Question: Express in one sentence what the figure is showing.
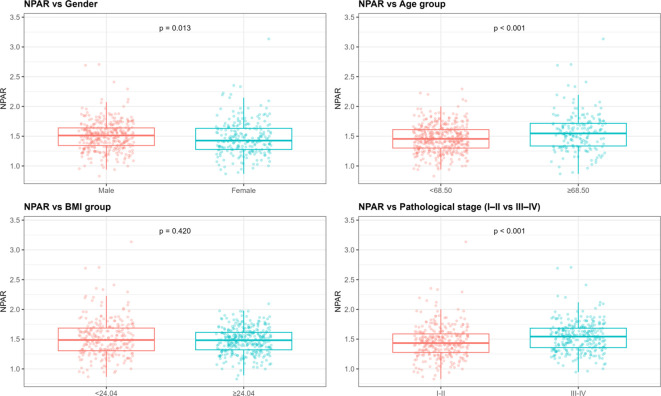
Answer: Distribution of NPAR according to sex, age group, BMI group, and pathological stage in the training cohort.